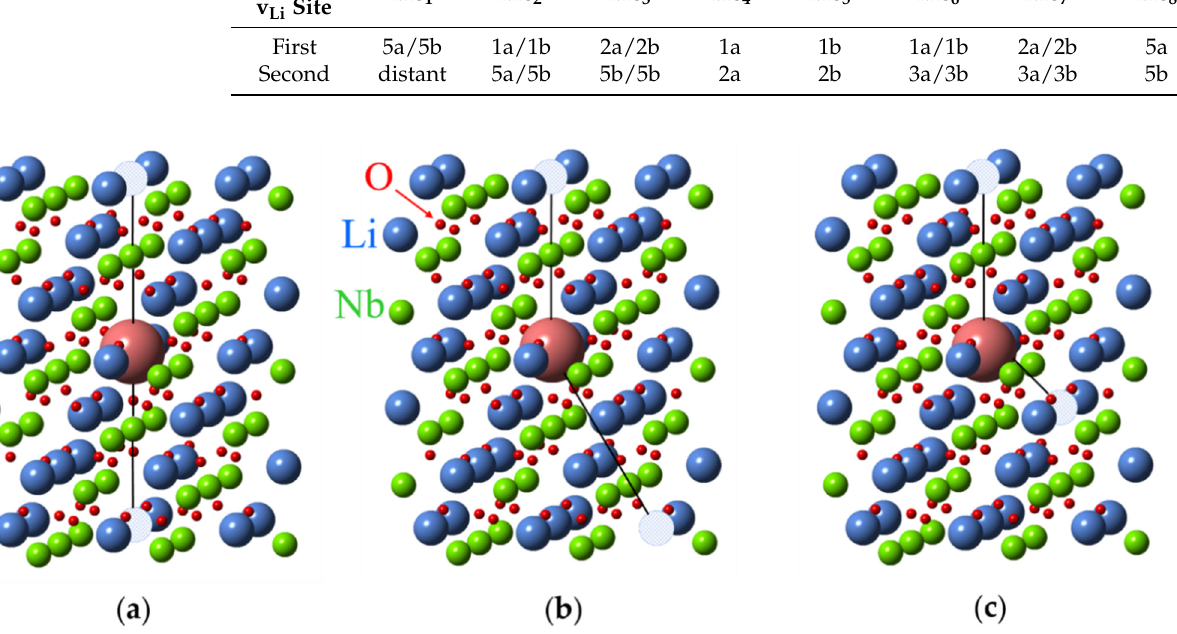
Figure 8. Divacancy models for an impurity substituted for Li + ion in LN crystal lattice. Hatched circles represent two v Li . ( a ) Axial center, ( b ) nearly axial center, ( c ) low-symmetry center.